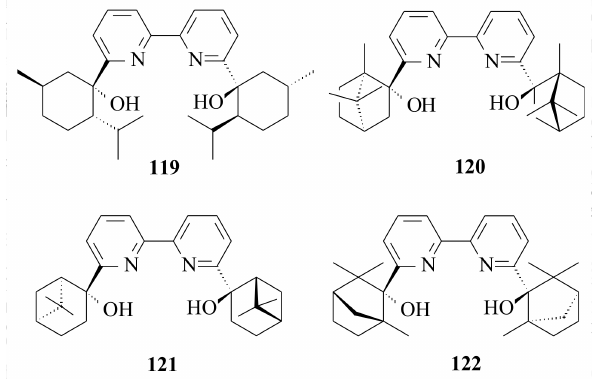
Figure 24. C 2 -symmetric chiral bipyridinyl diol